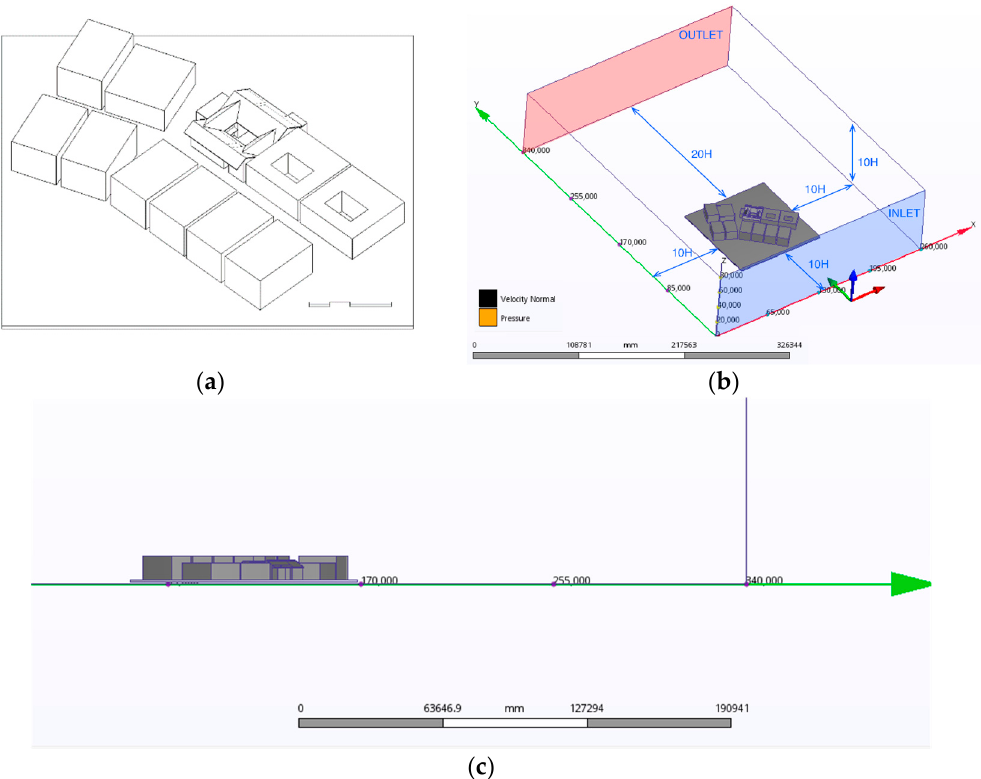
Figure 7. ( a ) Computational domain used for CFD simulation (H = 8 m), ( b ) geometry of the building and surrounding buildings, and ( c ) section of the computational domain.